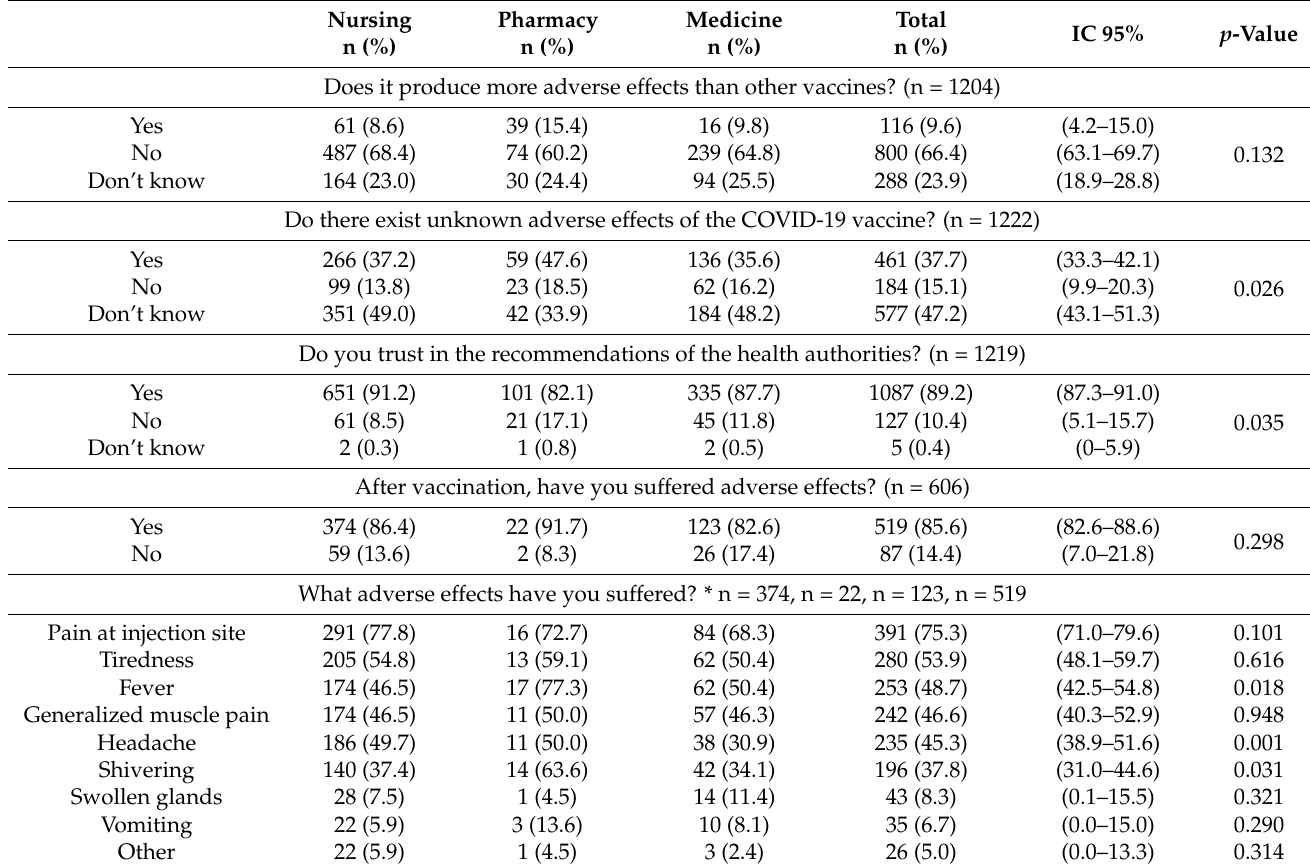
Table 4. Beliefs and occurrence of adverse effects after the administration of the COVID-19 vaccine. (n =